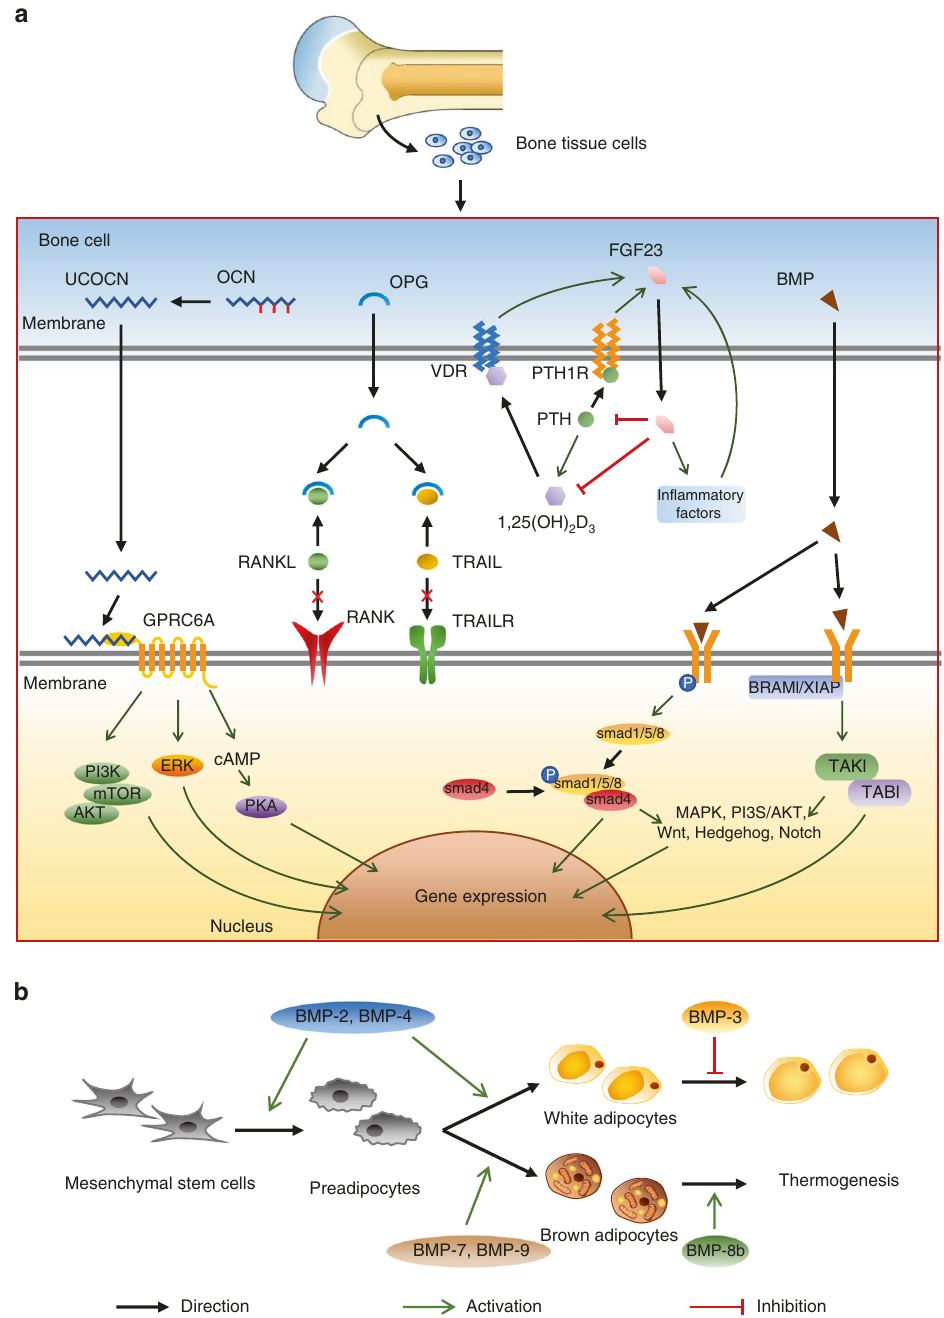
Fig. 2 Metabolic regulation of factors derived from cells in bone tissue. a OCN can be decarboxylated in osteoblasts, transformed into unOCN, and secreted into the blood. It can primarily bind to the GPRC6A receptor on the cell membrane and activate downstream PI3K/mTOR/Akt signals to affect gene expression. OPG, as a competitive ligand of RANK and TRAIL receptors, can combine with RANK and TRAIL to reduce the distribution of RANK/RANKL and TRAILR/TRAIL on the cell membrane and further affect gene expression. FGF23 can regulate energy metabolism by forming a feedback regulation loop with 1,25(OH) 2 D 3 and PTH. BMP is mainly derived from osteocytes. Different kinds of BMPs can combine with type I and type II serine/threonine kinase receptors on the cell membrane and can interfere with important downstream pathways, such as MAPK, PI3K/Akt, Wnt, hedgehog, and notch, through Smad protein-dependent or Smad-independent pathways, playing a role in regulating metabolism. b The BMP family in fl uences the key steps of fat production and preadipocyte differentiation into WAT and BAT and regulates the function of